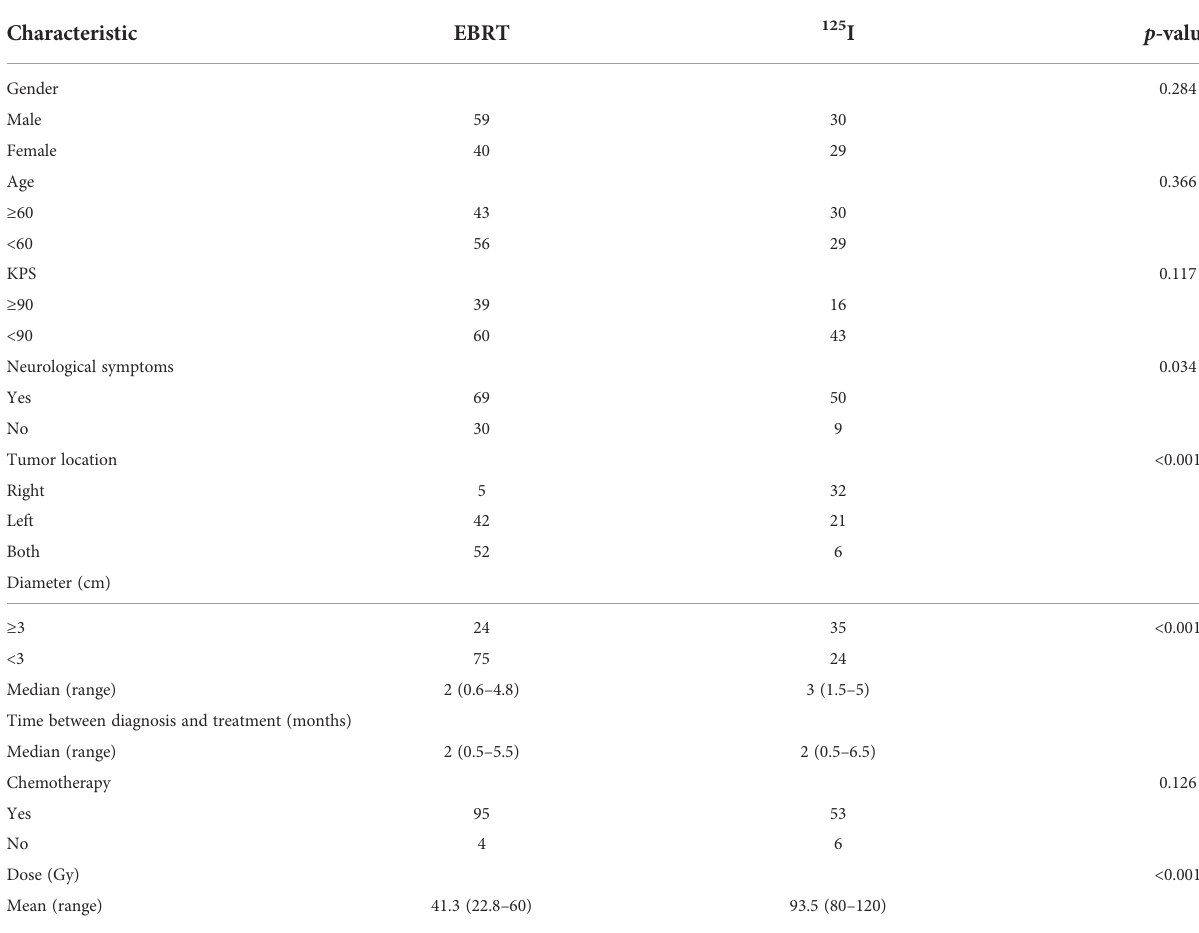
TABLE 1 Characteristics of NSCLC patients with BMs in the two